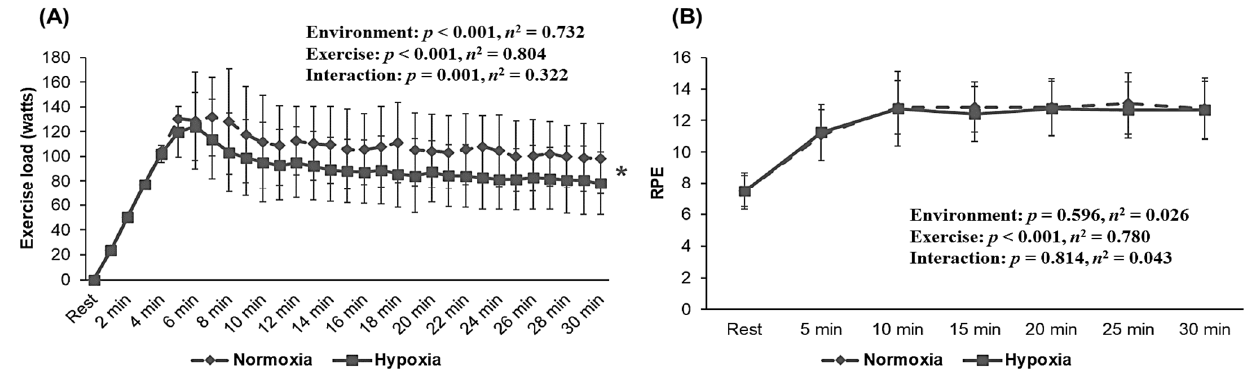
Figure 3. Changes in exercise load and RPE during 30 min of endurance exercise at the same HR level (136.5 ± 1.5 bpm) under normoxia (760 mmHg) and hypoxia (526 mmHg, simulated 3000 m). ( A ) Exercise load, ( B ) RPE. HRmax: maximal heart rate; RER: rating of perceived exertion. The bars indicate the mean ± S.D. *: Significant difference within the environmental condition (normoxia vs. hypoxia) during 30 min of endurance exercise.